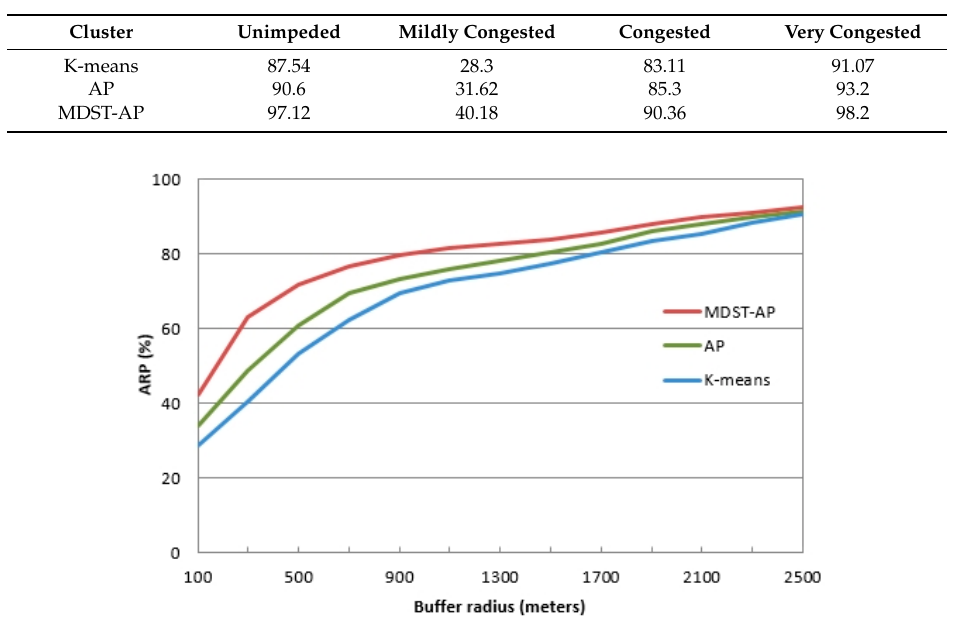
Table 6 indicates that the average ARP values for the k-means algorithm, AP algorithm, and